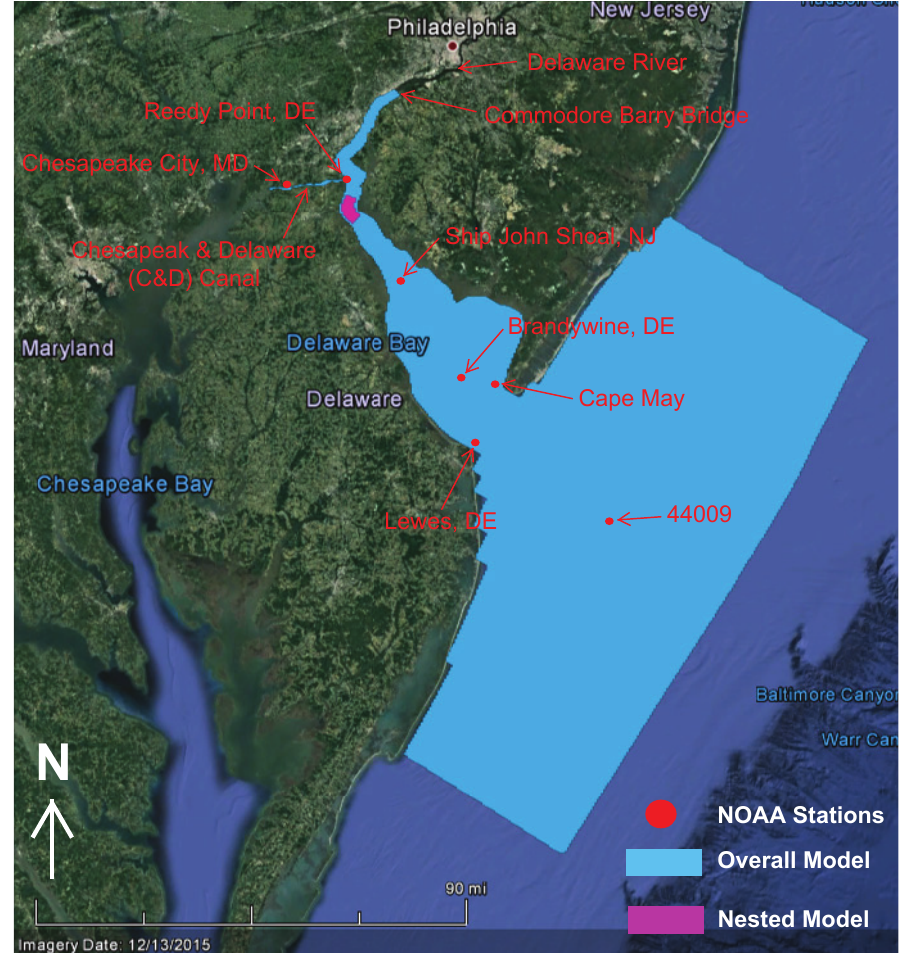
Figure 1. Geographical extent of the study